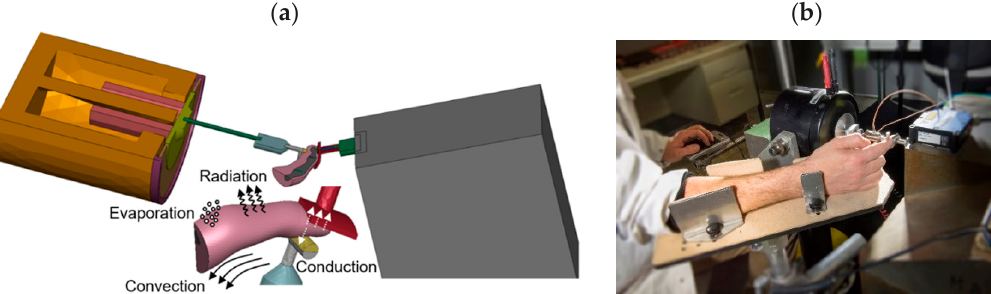
Figure 4. Thermal model and the adapted experimental setup. ( a ) modeling; ( b ) apparatus.